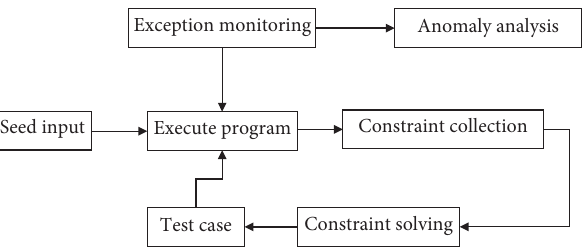
Figure 1: The general process of detecting software vulnerabilities using signal